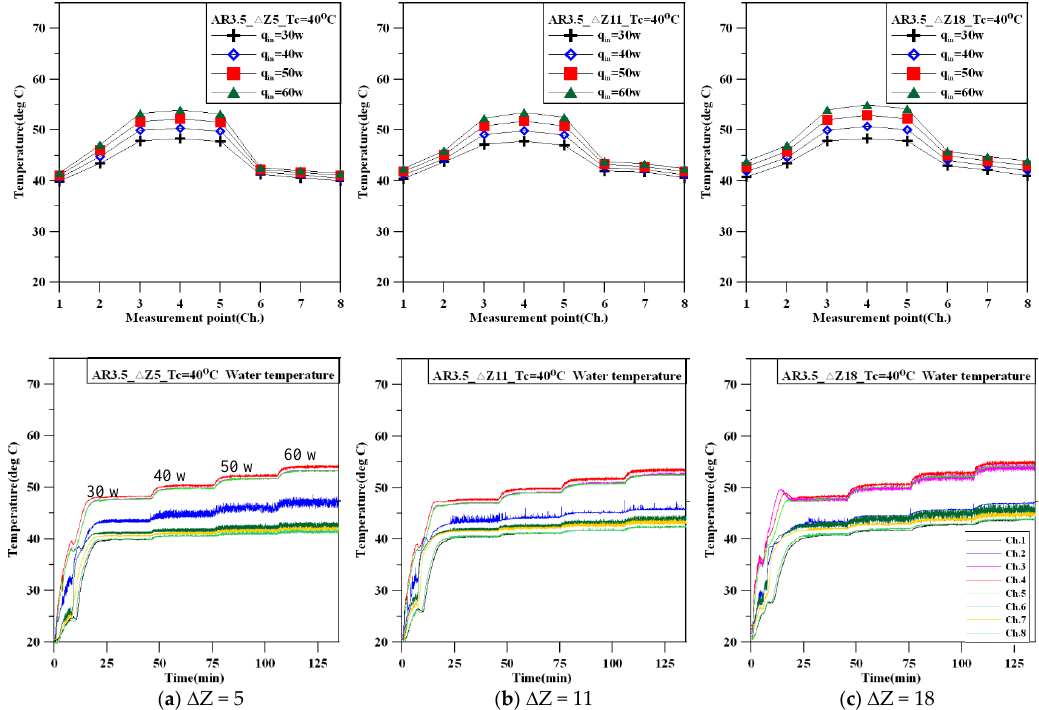
Figure 3. Fluid temperature variation along the loop as a function of the heating power (AR = 3.5, Tc = 40 °C, Z = 5, 11, and 18).